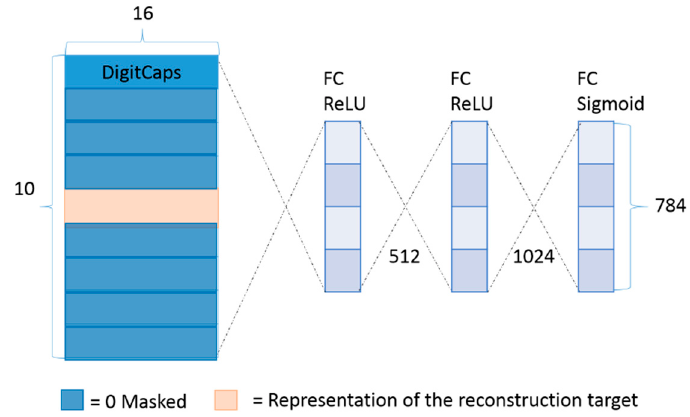
Figure 21. The decoding unit where a digit is reconstructed from DigitCaps layer representation. The Euclidean distance is used minimizing the error between the input sample and the reconstructed sample from the sigmoid layer. True labels are used for reconstruction target during training.